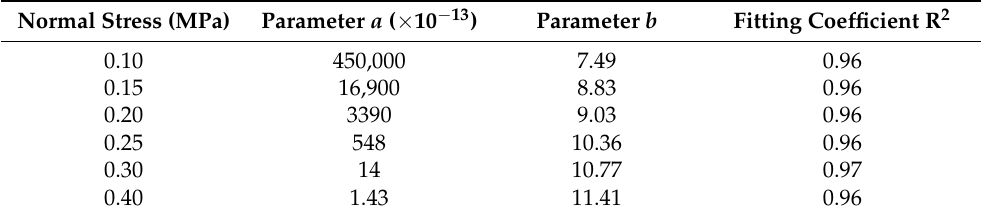
Table 5. Fitting parameters a , b and fitting coefficient R 2 of the JRC and Re · f /96 curve.